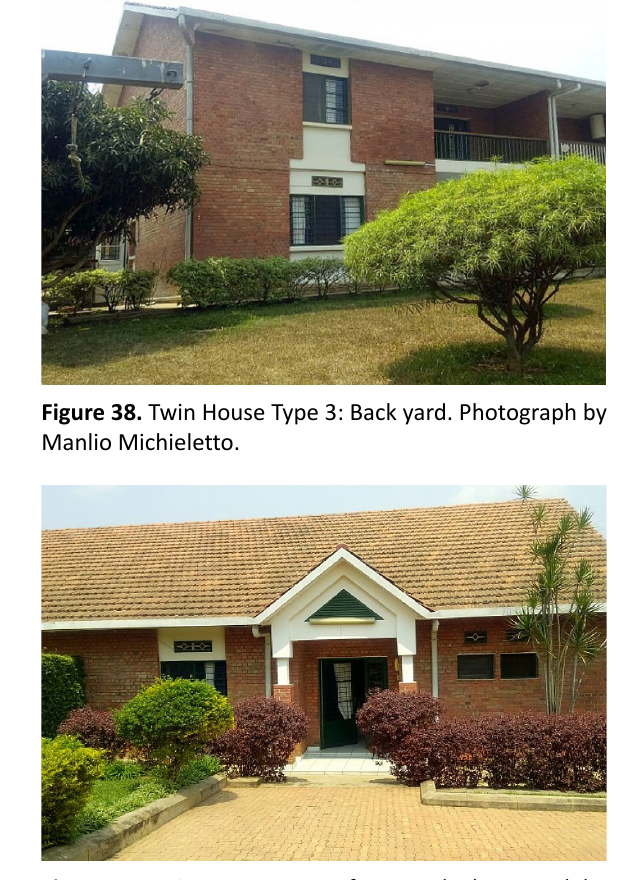
Figure 39. Twin House Type 3: front yard. Photograph by Manlio